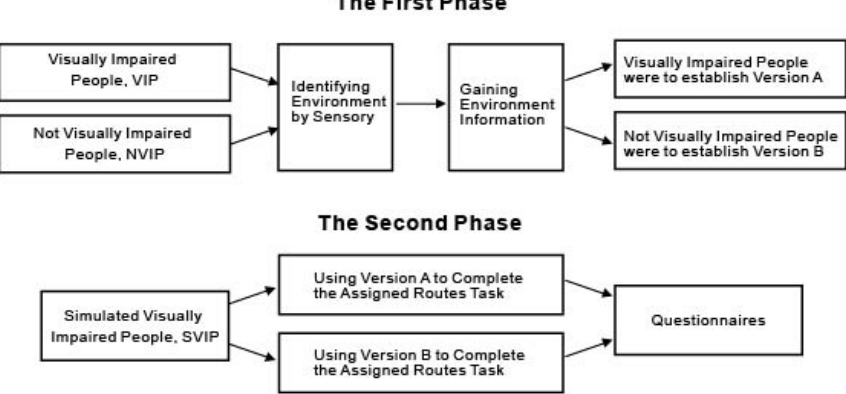
Figure 1. Procedures of the experiment.